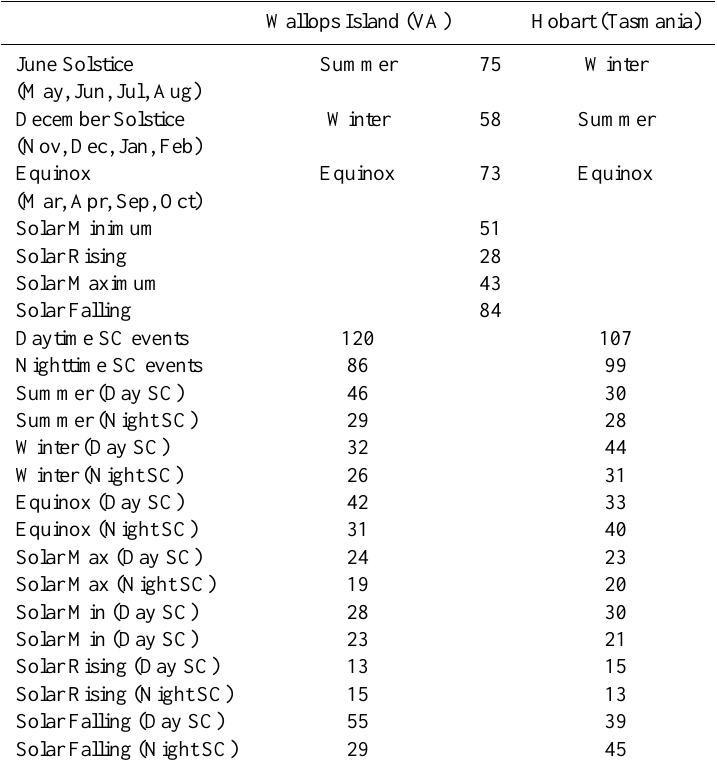
Table 2. Distribution of Storms by Season, Phase of the Solar Cycle, and Local Times of Storm Commencement (SC) for Wallops Island and Hobart.